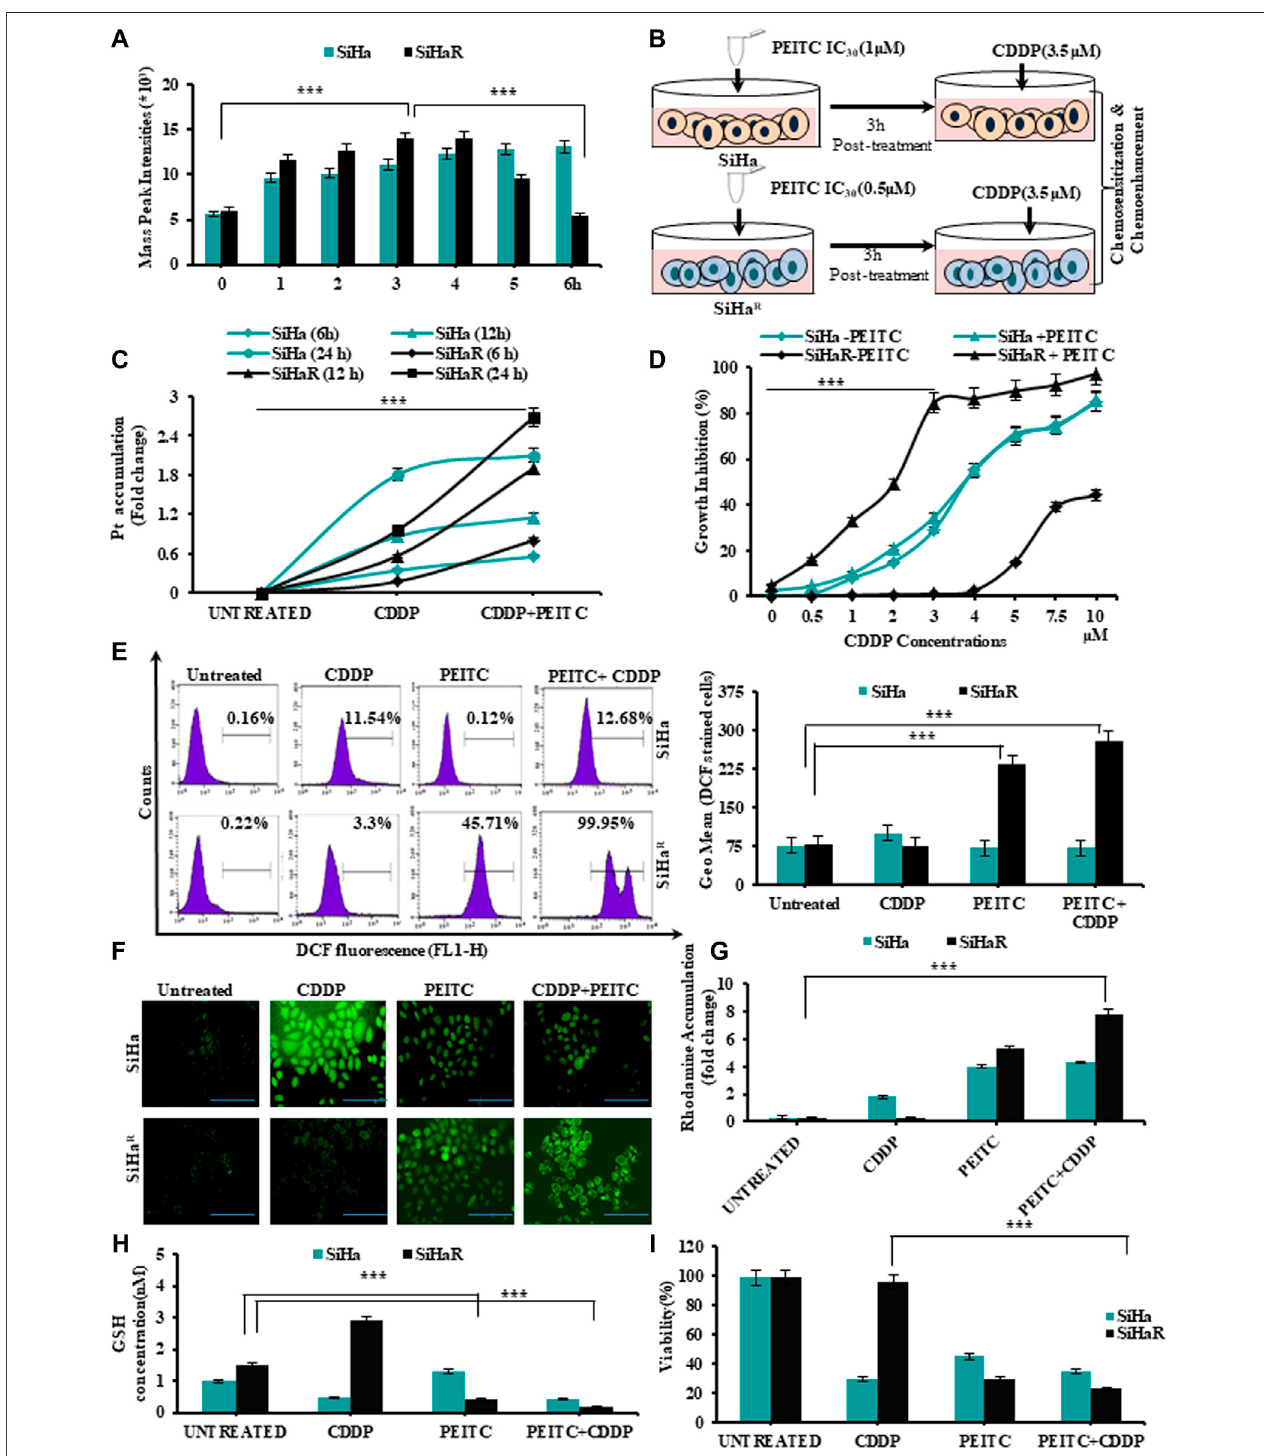
FIGURE2|(A) MassspectroscopicanalysistoidentifytheoptimumtimepointofPEITCuptakeandretentioninCDDP-sensitiveand-resistantcells. (B) Schematic outline of the entire treatment design followed for validating the effects of PEITC as a cisplatin chemosensitizer and chemoenhancer. (C) Time-dependent intracellular accumulationofCDDPinSiHaandSiHa R cellsuponexposureto3.5 µMofthedrugfollowingPEITC(IC 30 dose)pre-treatmentfor3 h. (D) Comparativegrowthinhibition of SiHa and SiHa R in a varied range of CDDP doses for 24 h in absence and presence of PEITC pretreatment for ascertaining optimum combinatorial dose. (E) HistogramplotsdisplayingFL1peakshiftsduetoROSgenerationrepresentedbyDCFHDAstainedcells(SiHa R